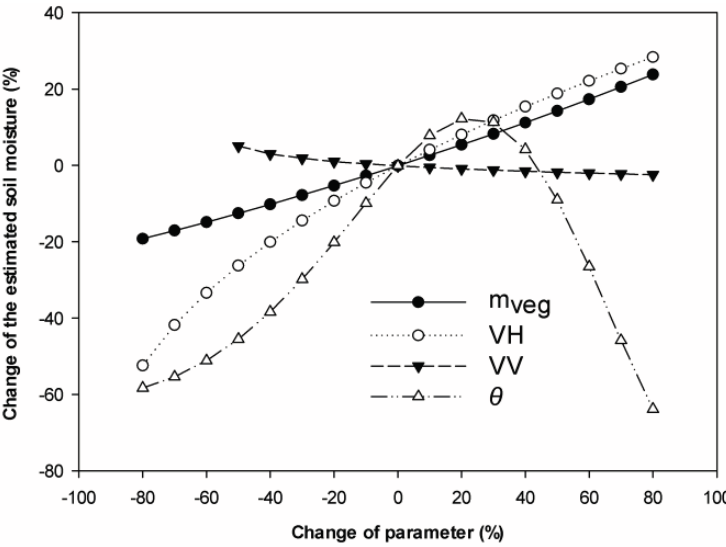
Figure 4. The analysis of sensitivity of parameters in model